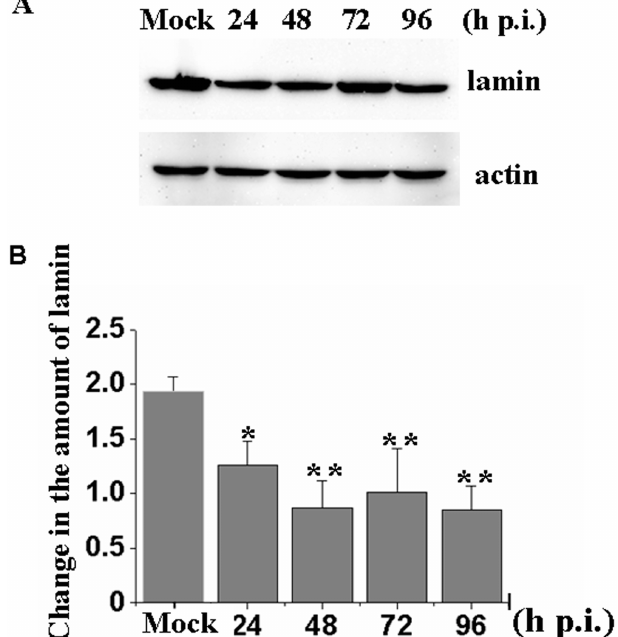
Figure 3. Examination of the amount of lamin during AcMNPV infection. ( A ) Sf9 cells were infected with vAcBac at amultiplicity of infection (MOI) of 5. At various time points (24, 48, 72, 96 h p.i.), the cells were harvested, and the proteins were separated on a 10% polyacrylamide gel and analyzed by western blotting using the anti-­‐‑Dm0 monoclonal antibody, ADL67, or anti-­‐‑actin antibody, and the bound antibody was detected with the HRP-­‐‑labeled secondary antibody. ( B ) Western blotting analysis of changes in the amount of lamin during baculovirus infection. Amounts of lamin were determined by measuring of band densities using Image-­‐‑Pro Plus 5.0 software. Obtained values were adjusted to actin levels. Mean values (± SE) of lamin protein levels of three different experiments are shown. The Dunnett t tests were used to compare the difference between the total amount of lamin in vAcBac-­‐‑infected cells at 24, 48, 72, 96 h p.i. with those in the mock-­‐‑infected cells ( * p < 0.05, ** p < 0.01) after an F test.